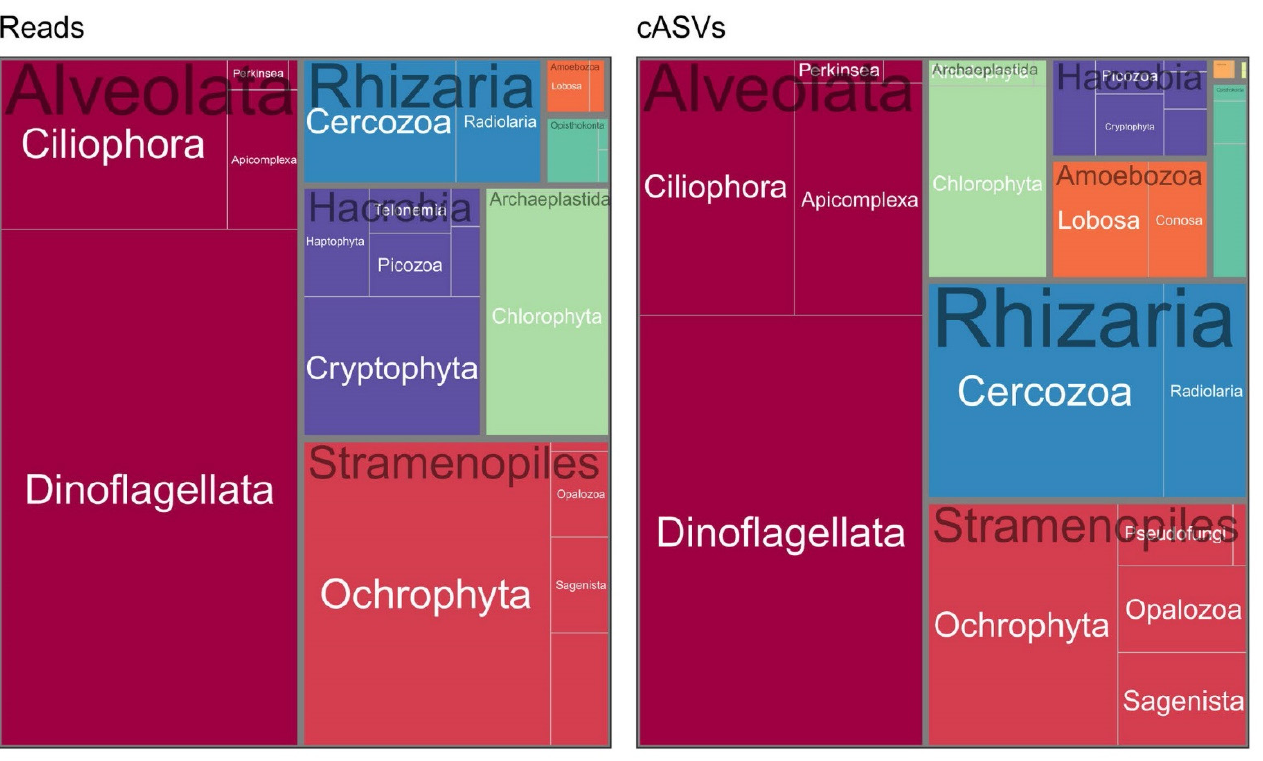
Figure 3. Treemaps of most abundant protist taxa (supergroups and divisions) for V4 datasets based on number of reads after normalization ( left ) or number of clustered ASVs (cASVs, ( right )). Molecular Ecology Resources, volume: 22, issue: 8, pages: 3188–3201, first published: 28 June 2022, DOI: (10.1111/1755-0998.13674) [41].